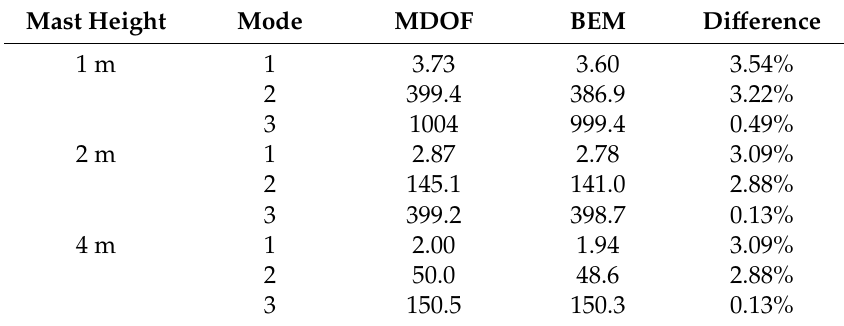
Table 8. First three natural frequencies of the MDOF model and BEM of the H-type VAWT with di ff erent mast